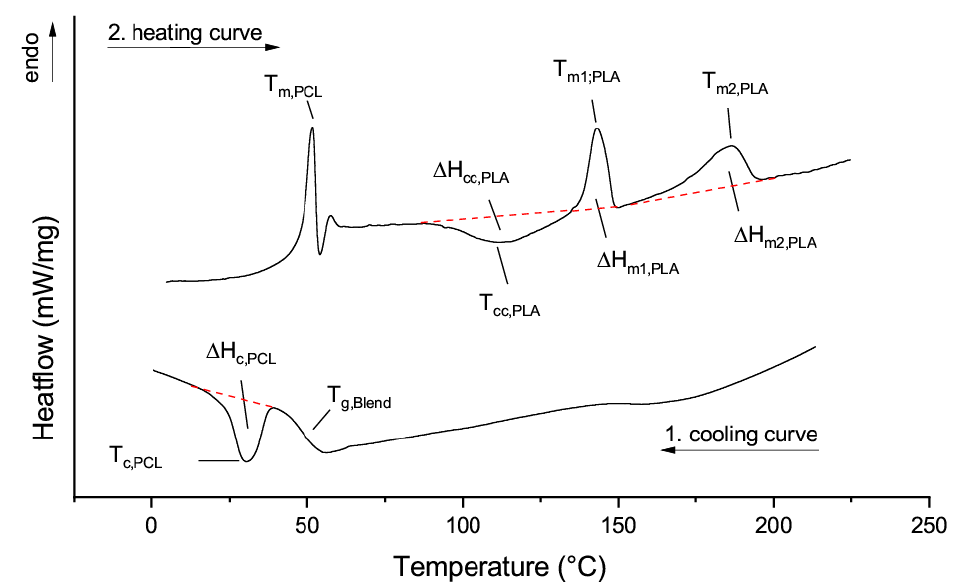
Figure 3. DSC analysis of the blends PLLA and PDLA-b-PCL block copolymers, left: top: 2nd heating run, bottom left: 1st cooling run.